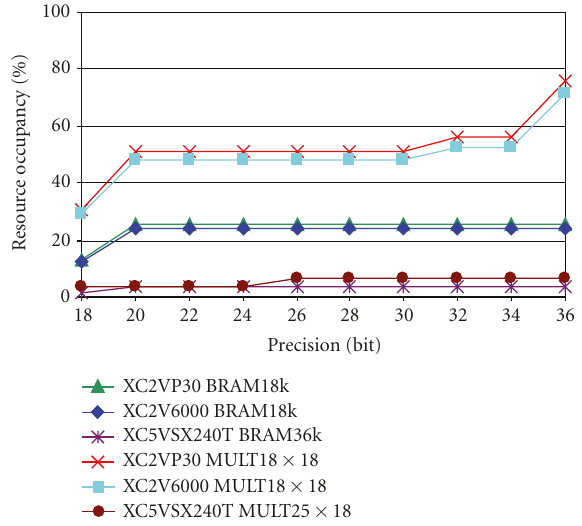
Figure 9: Dedicated resource (multiplier, block-ram) requirements on di ff erent FPGAs.